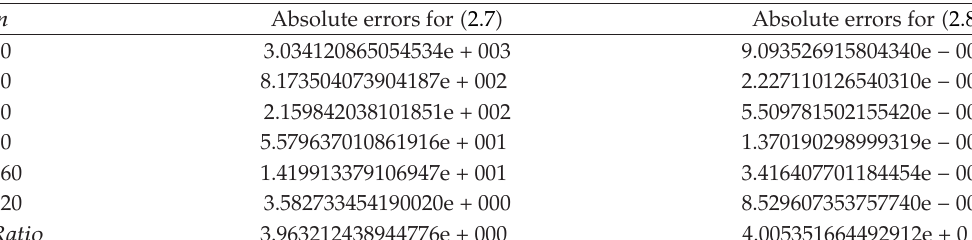
Table 7: Equation (cid:6) 4.13 (cid:7) in case of 2-step BDF methods for (cid:6) 2.7 (cid:7) and (cid:6) 2.8 (cid:7) .